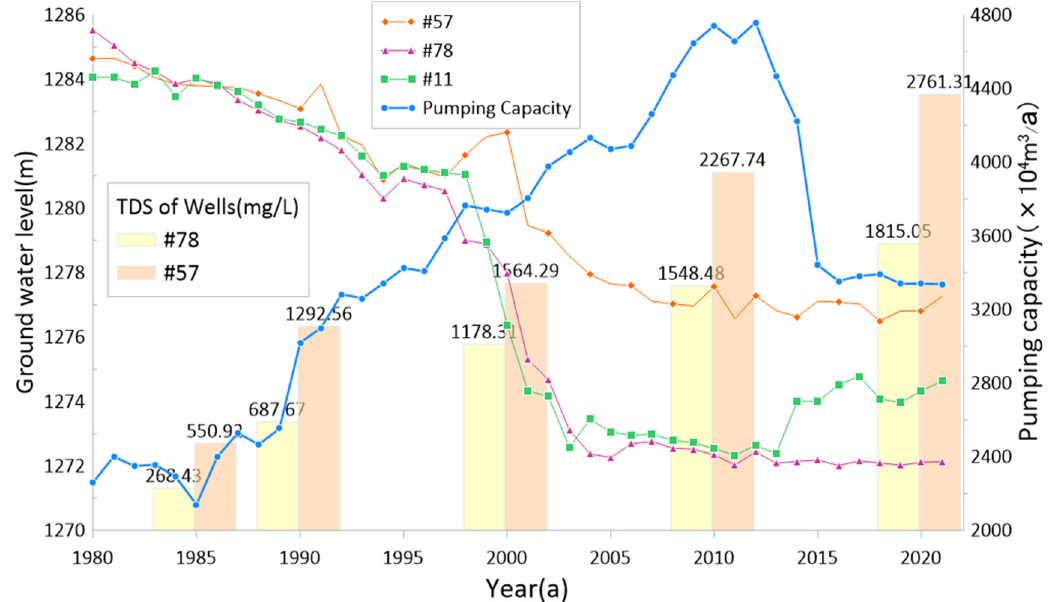
Figure 10. Relationship between pumping capacity, water level, and TDS in groundwater of the Yaoba Oasis.